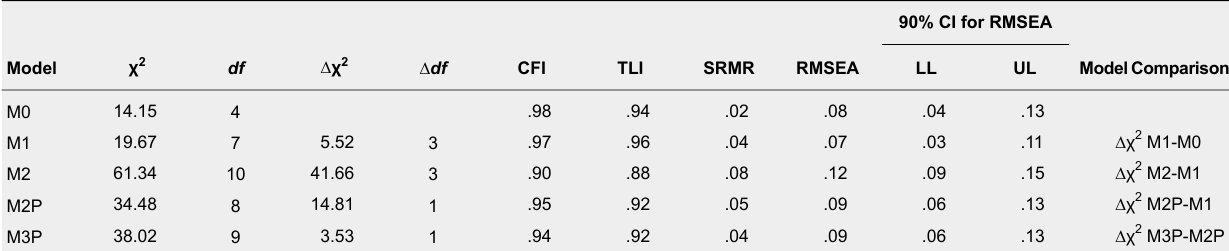
Goodness-of-fit Indices and Comparison of Models Testing Measurement Invariance for Legitimacy of Protests (Original